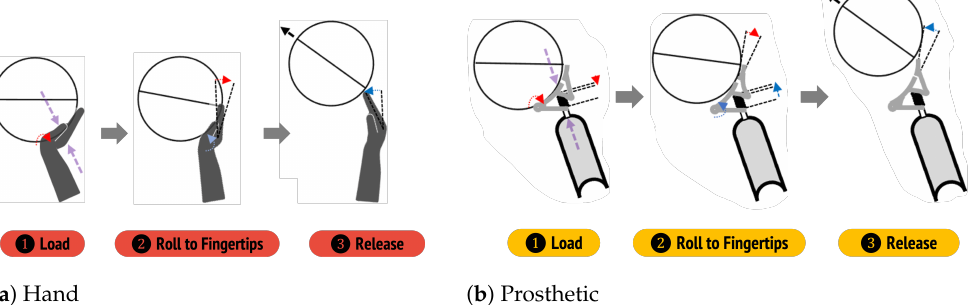
Figure 9. Hand movements in a typical overhead basketball shot ( a ) and their analogs in the presented prosthetic ( b ).